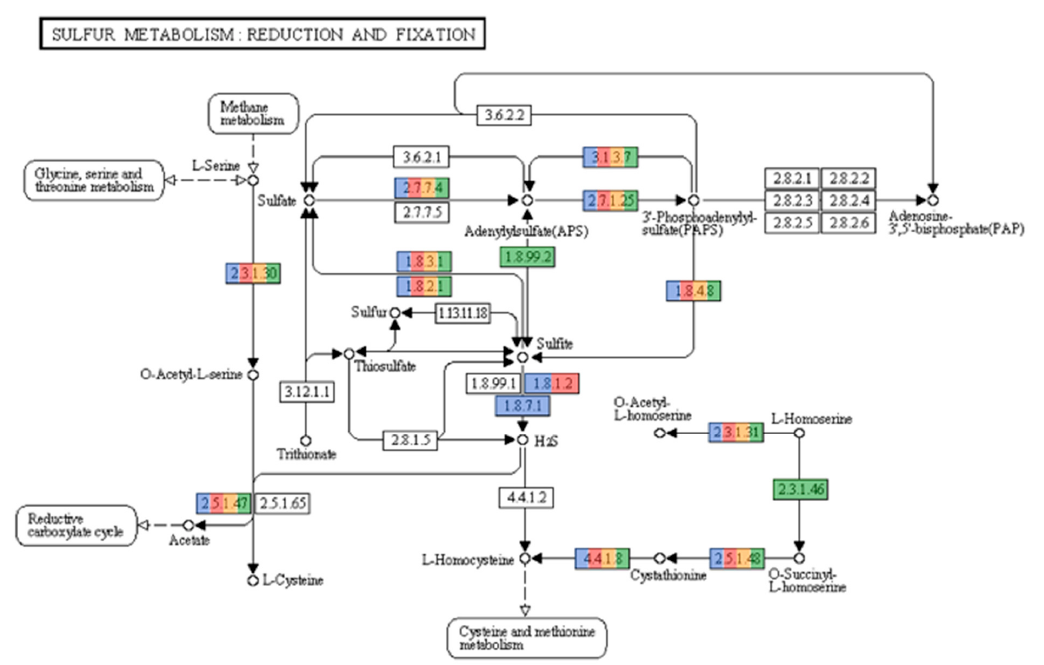
Figure 6. Sulfur metabolism pathways present in the metagenomes. Colored enzymes indicate the presence of hits related to the enzyme in the metagenome (number of hits for each enzyme can be seen at Table S1 of supplementary figures). Enzymes related to sulfate reduction (2.7.7.4, 1.8.99.2, 1.8.1.2, 1.8.7.1) were encountered. Pathways obtained from KEGG pathways ( https: // www.genome.jp / kegg / pathway.html ) with